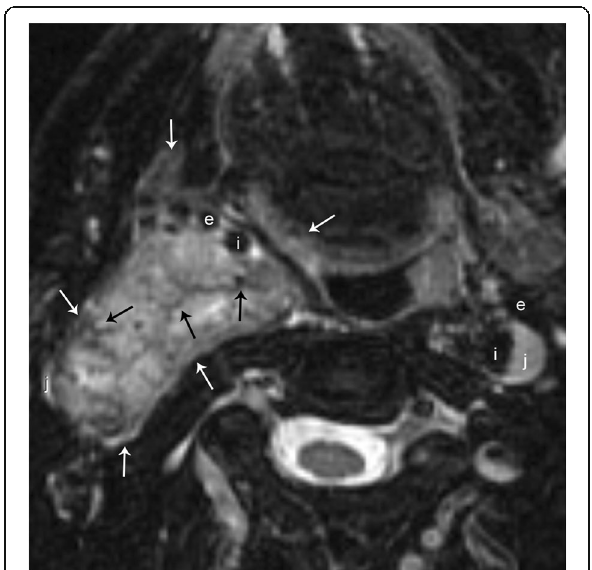
Fig. 4 Glomus vagale. Axial T2-weighted MR image with fat suppression shows a well-circumscribed hyperintense mass (white arrows) with an internal “ salt and pepper ” appearance. This appearance is due to signal voids of tumor vessels (black arrows) and high signal areas due to slow flow and/or hemorrhage. Note the anterior displacement of the right internal (i) and external (e) carotid arteries, and lateral displacement of the right internal jugular vein (j). The vessels are labeled in their normal configuration on the left